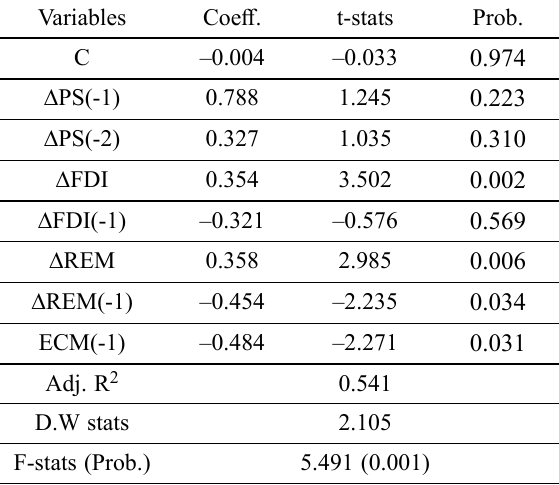
Table 6. Short run results using ARDL